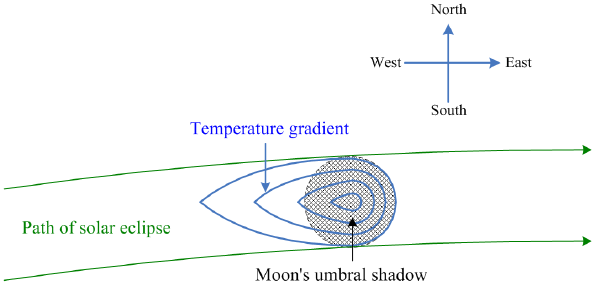
Fig. 5. The schematic diagram of the proposed mechanism for the Es